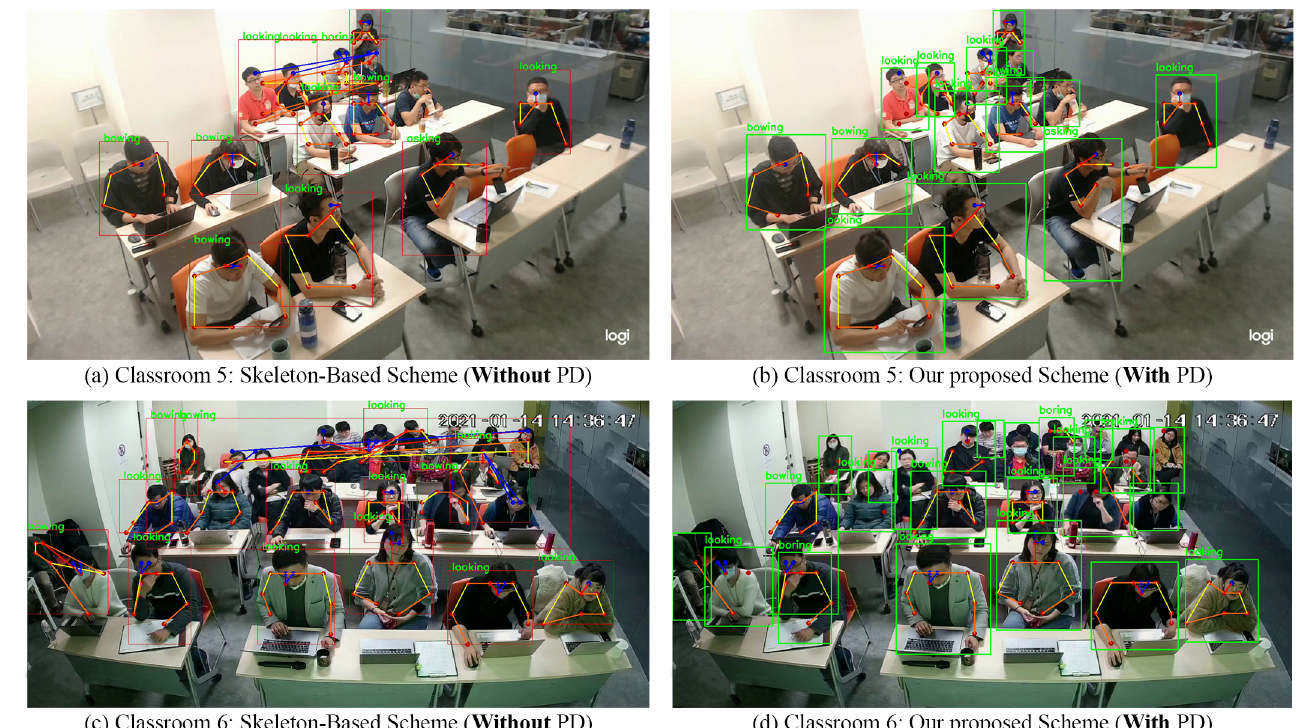
Figure 13. Comparison of the two schemes in Classrooms 5 and